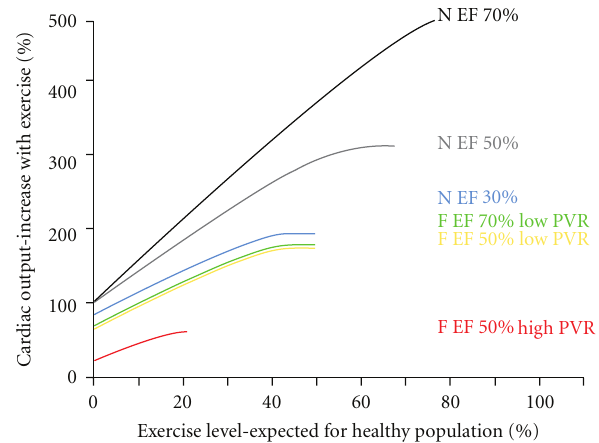
Figure 2: Relationship of output during exercise, pulmonary vascular resistance (PVR), and ventricular function. Cardiac output can increase 5-fold in a normal (N) subject with a biventricular circuit. If ventricular function is impaired, this will first result in decreased maximal output and subsequently in reduced output at low level of exercise. In Fontan patients (F) output is more influenced by PVR than by ventricular function but all have significantly impaired exercise capacity. EF: ejection